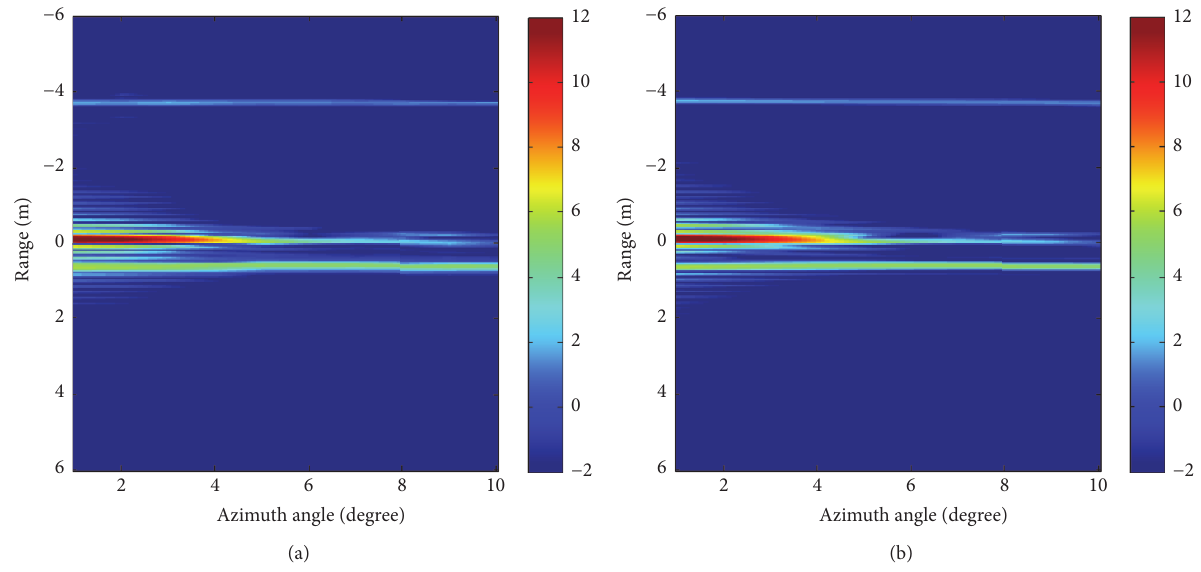
Figure 13: RP history of target I. (a) Simulated RP history of target I; (b) real RP history of target I.